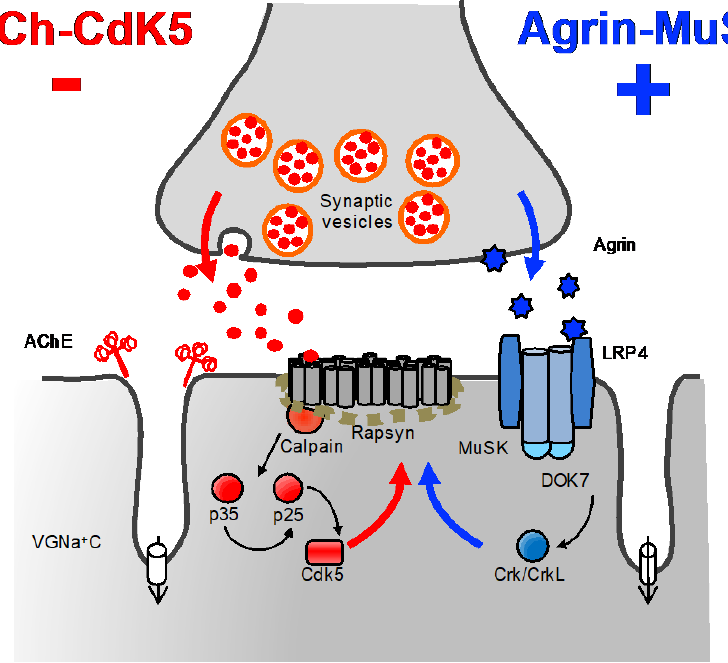
Figure 6. The agrin-induced AChR clustering and ACh-CdK5 dispersal pathways. The AChR clustering pathway is shown blue and the dispersal pathway in red. Main molecules with a role in synapse formation and maintenance are represented although additional, still unknown, positive and negative factors are very likely to be involved. CMS patients harboring mutations within the AChR clustering pathway (excluding RAPSN ) present common clinical features such as relative sparing of eye muscles, predominant limb girdle weakness, worsening of symptoms with drugs increasing ACh levels, and improvement on long-term therapy with β 2-adrenergic agonists. DOK7 CMS represents the most frequent subtype in this category with other syndromes being rather